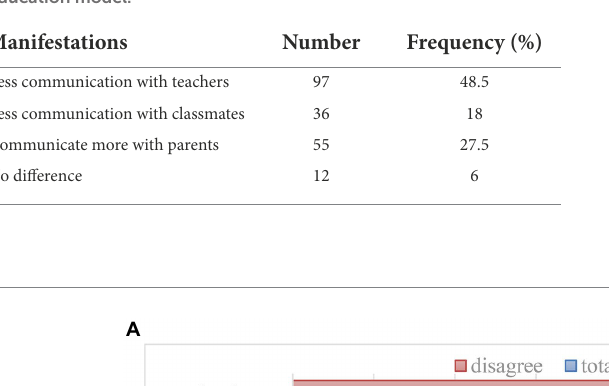
TABLE 2 The influence of college students’ emotions under the online education model.